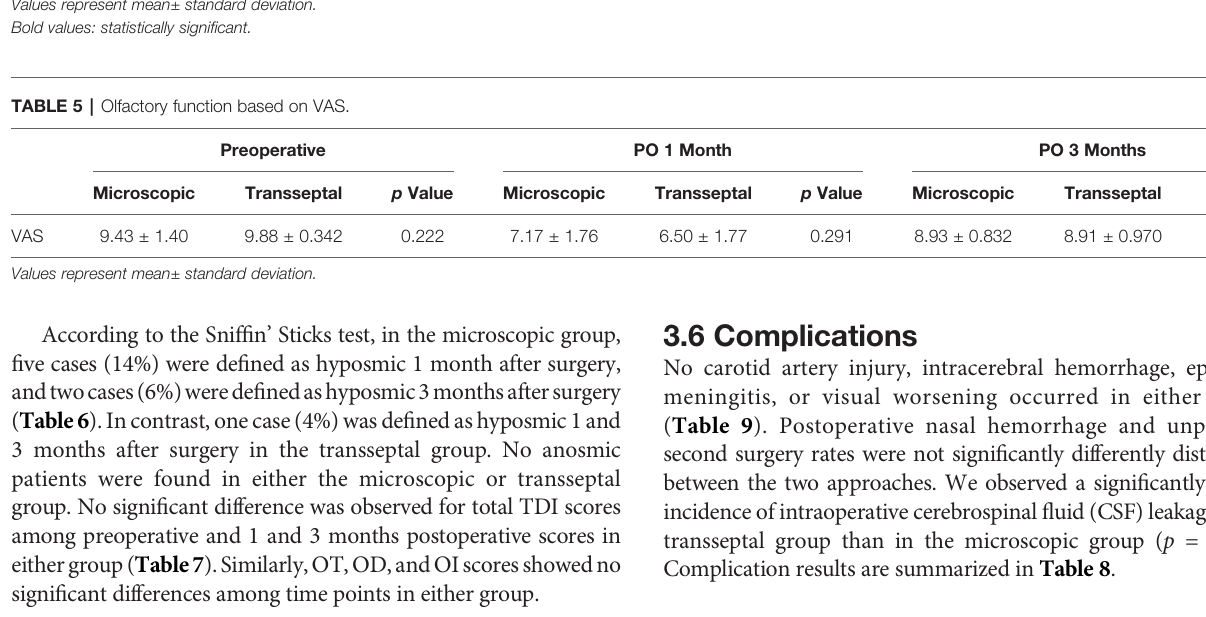
Values represent mean± standard deviation. Bold values: statistically signi fi cant.